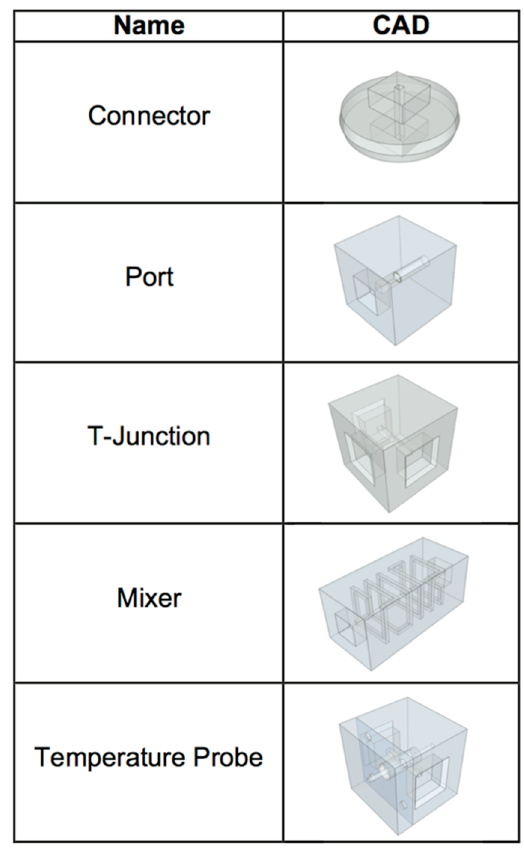
Figure A1. Library of discrete microfluidic elements used in this study. All channels had square cross-sections and were 642.5 µm wide (as designed). In keeping with the standard geometric constraints of discrete microfluidic elements previously demonstrated, each component was a constrained to a single cube of 1 cm side width. Connectors were 6 mm long and the mixer was 2.6 cm long, the equivalent length of two standard cubes and one connector.